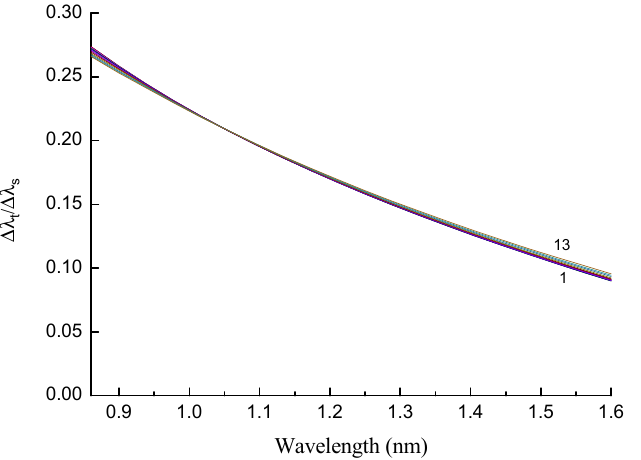
Figure 15. Temperature dependence of figure of merit for a 20 mm grating in B/Ge#1 fiber for modes LP 11 –LP 1,13 and ∆ T = 10K (290–300 K).